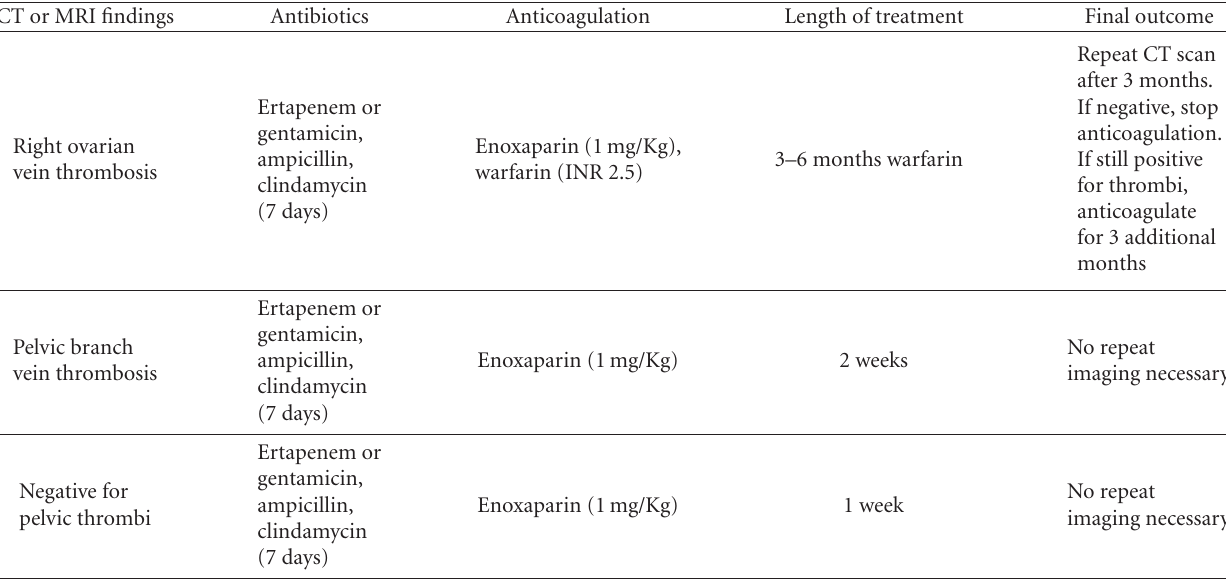
Table 1: Diagnosis and management for presumed septic pelvic